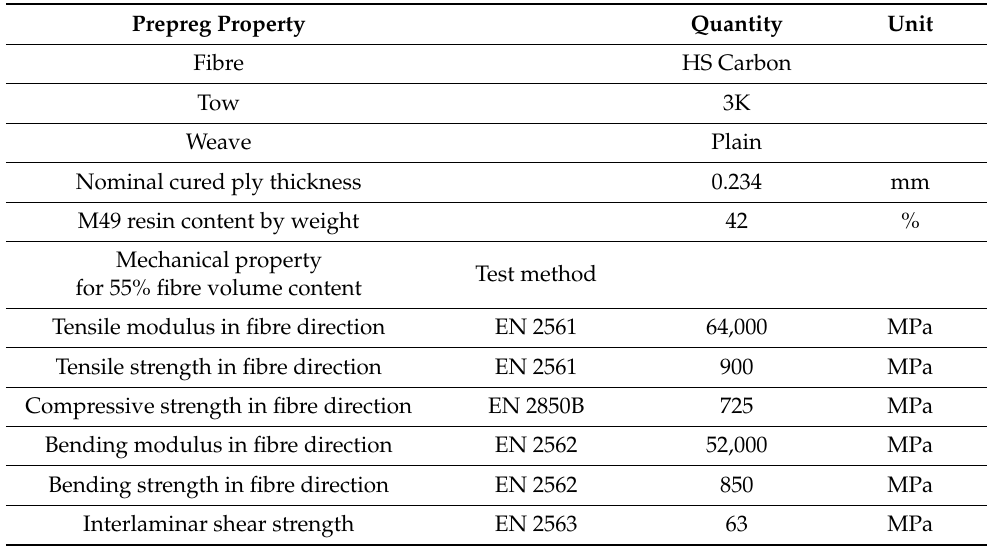
Table A1. HexPly M49 200P data sheet from supplier.